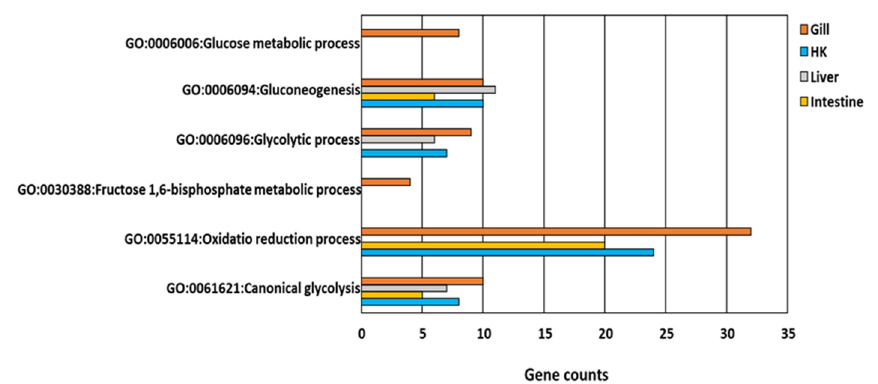
Figure 6. GO functions relative to glucose and energy metabolism in response to hypoxia in com- mon carp organs: Four organs, including the gill, head kidney (HK), liver, and intestine, had the same GO terms in GO:0006094~gluconeogenesis and GO:0061621~canonical glycolysis.